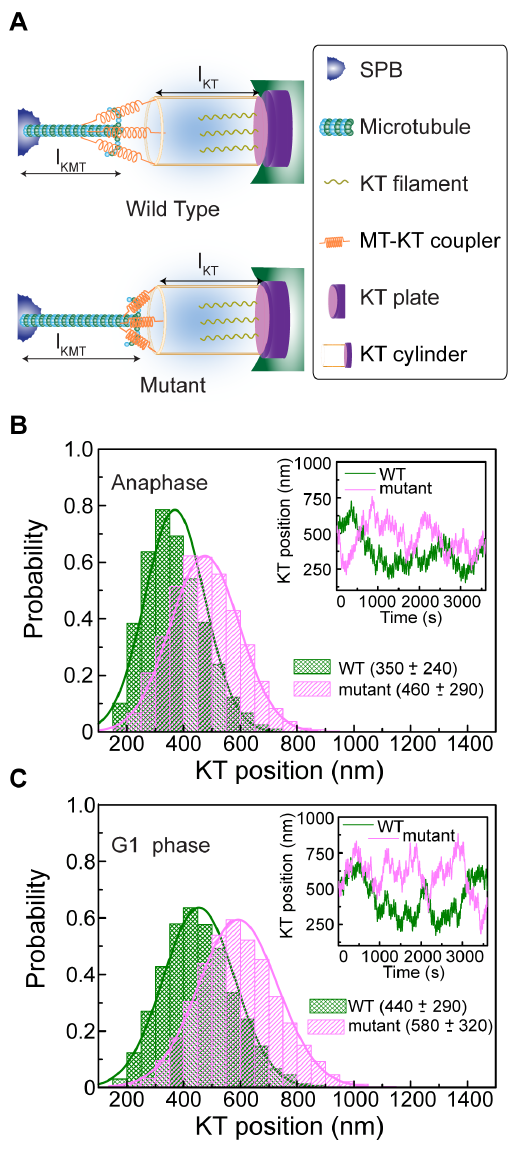
Figure 5. Altered rescue frequency of kMT predicts KT positioning. (A) Schematic is similar to Figure 4A. In this approach, the rescue frequency of the kMT is regulated by the tension applied on the kMT mediated by couplers. Mutation makes the couplers stiffer and thereby generates higher tension at the kMT tip. Thus in the mutant cell, frequent rescue of the kMT increases the equilibrium distance between SPB and KT. (B) Probability distribution of the KT position during anaphase, similar to Figure 4B. The average distances of the KT from the SPB are , 350 nm for the wild-type and , 460 nm for the mutant. Temporal change in the KT position for the WT (green) and the mutant (magenta) is shown in the inset. (C) Probability distribution of the KT position during G1 phase, plotted in the same manner as in (B). The average distances of the KT from the SPB are , 440 nm and , 580 nm for the wild-type and the mutant, respectively. Inset displays the time dependent position of the KT for both wild-type and mutant. doi:10.1371/journal.pone.0101294.g005 , 350 6 250 nm for the wild-type and , 460 6 290 nm for the mutant. Data obtained using G1 parameters (see Figure 5C) predict the mean KT distance as , 440 6 290 nm and , 580 6 320 nm for the wild-type and mutant respectively. All